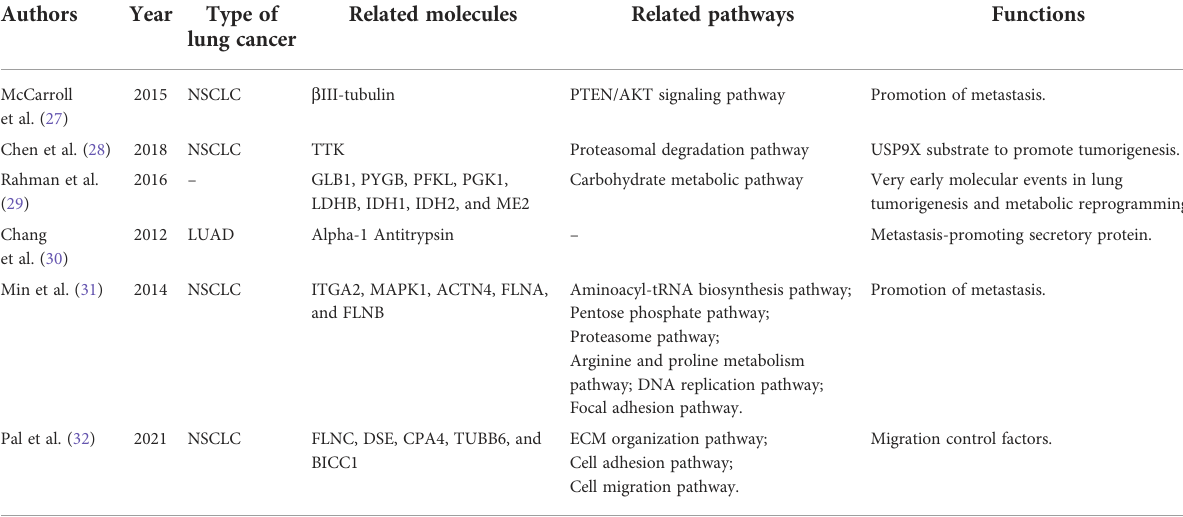
TABLE 1 Role in the tumorigenesis and progression of lung